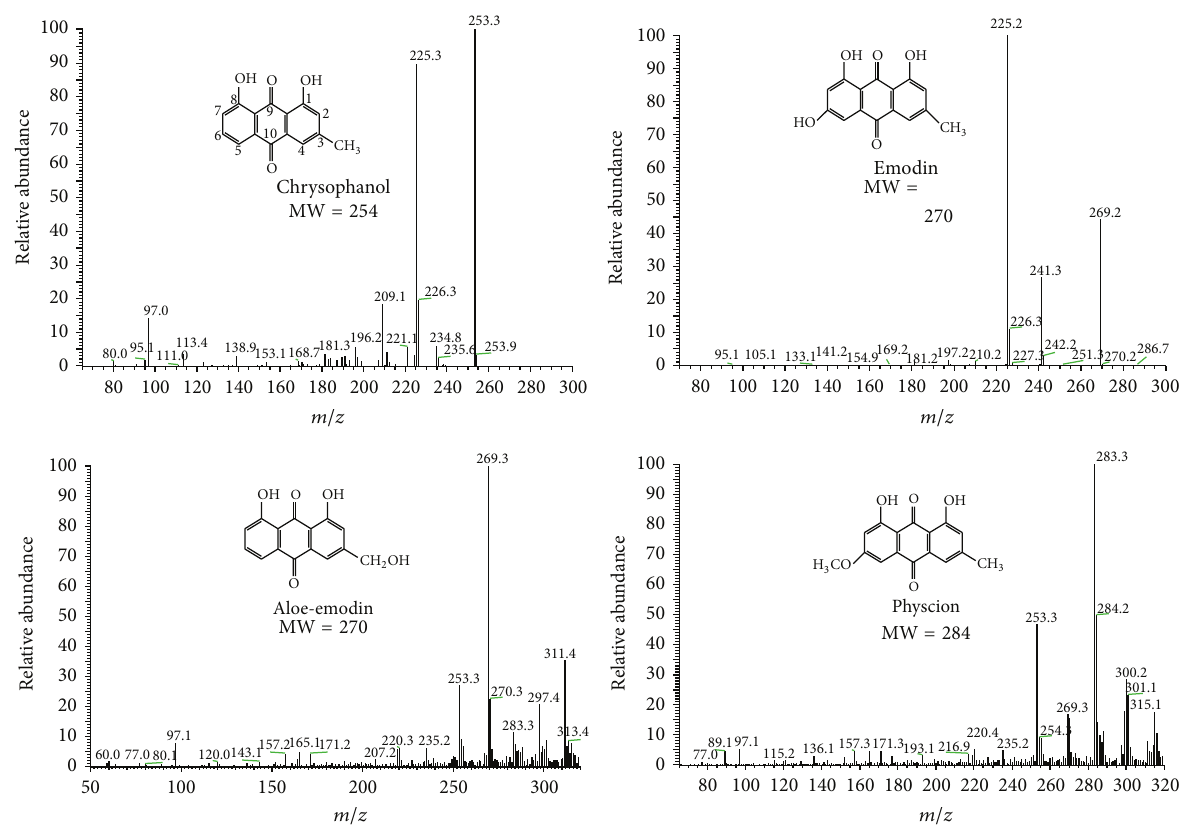
Figure 3: ESI-MS of rhubarb